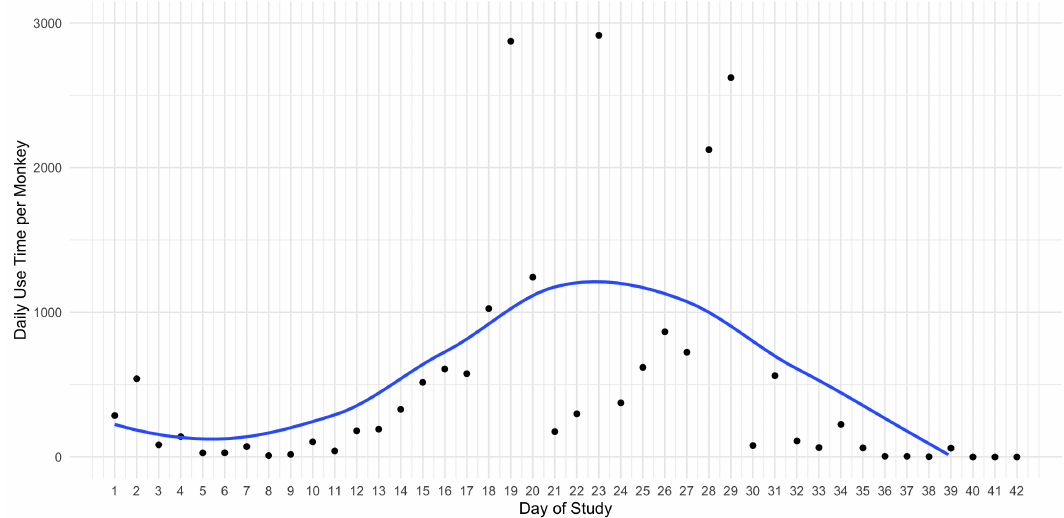
Figure 5. A monkey’s daily use time with the enrichment system with line of best